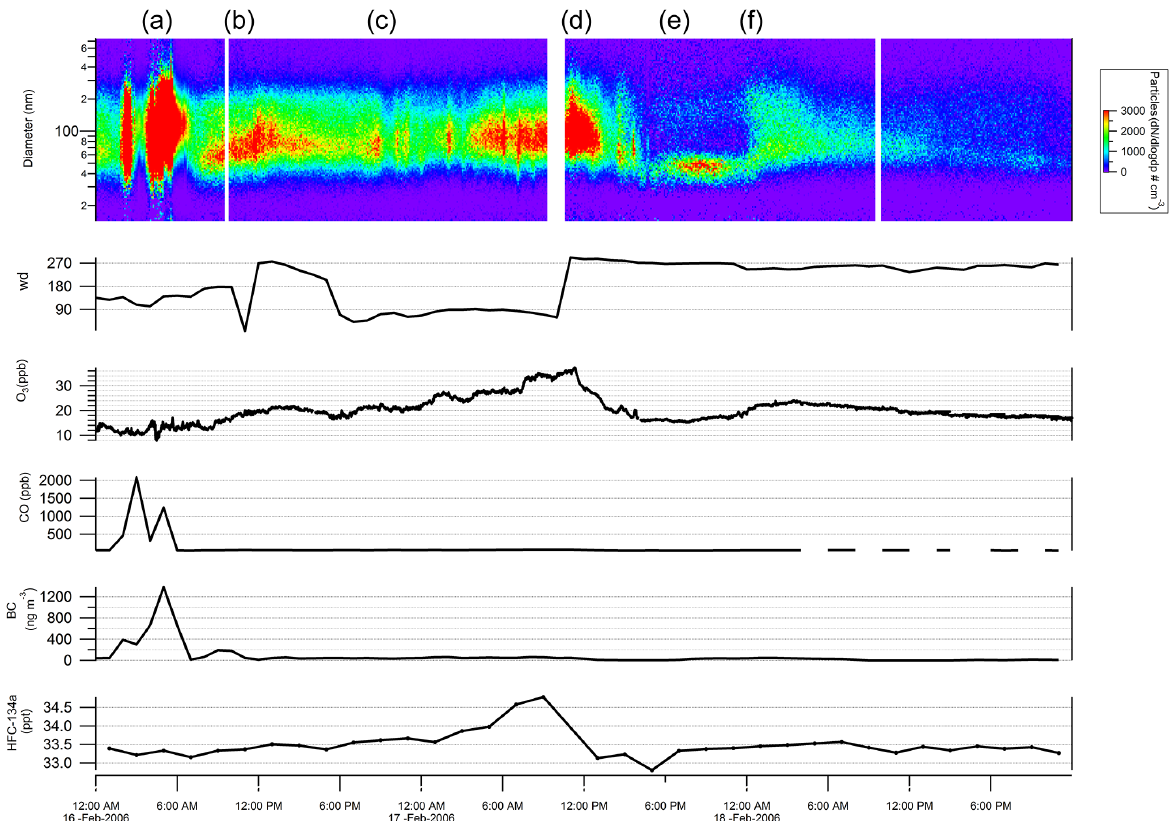
Figure 3. Time series from BB1 including a particle size and number contour plot, wind direction (degrees), ozone (O 3 ), carbon monoxide (CO), black carbon (BC) and HFC-134a. Periods A–F are discussed in the